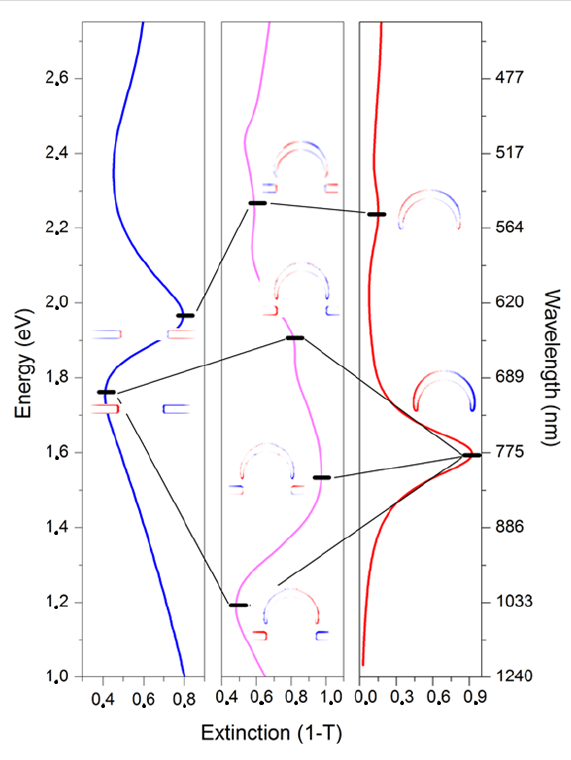
Figure 8: Hybridization diagram of the gold cap/hole structures showing the coupling between the hole and cap modes.